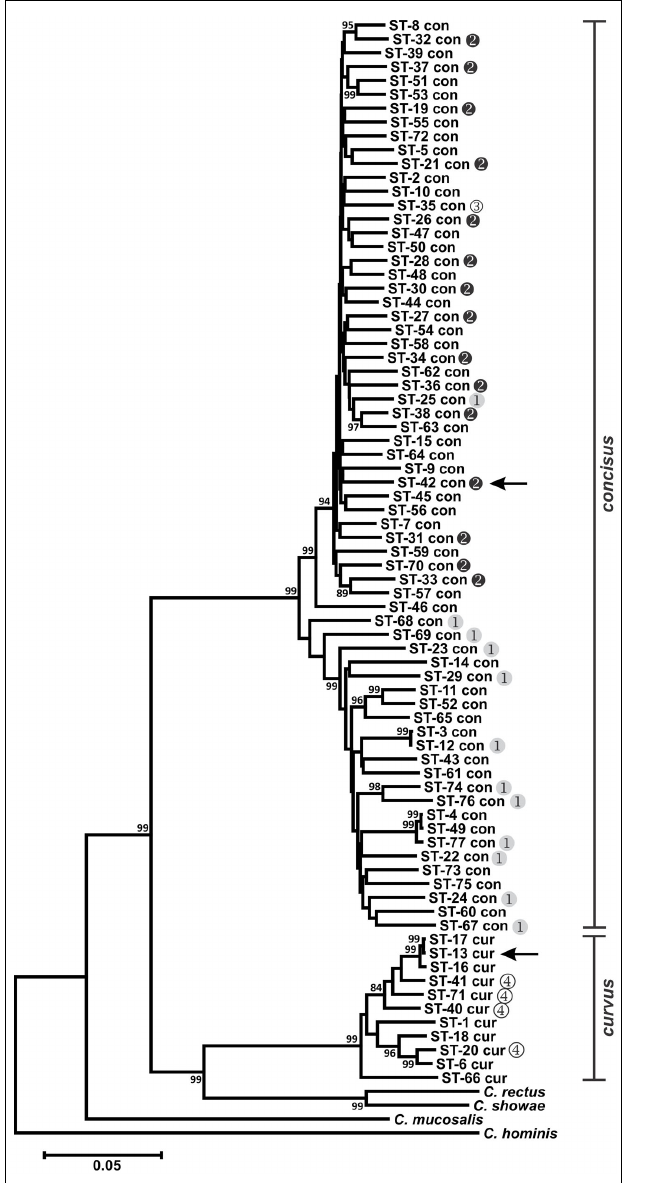
FIGURE 1 | Dendrogram of C. concisus and C. curvus STs. Allele sequences for each strain were concatenated in the order aspA - atpA - glnA - gltA - glyA - ilvD - pgm and aligned using CLUSTALX . The dendrogram was constructed using the neighbor-joining algorithm and the Kimura two-parameter distance estimation method (Kimura, 1980). Bootstrap values > 75%, generated from 1000 replicates, are shown at the nodes. Scale bar represents substitutions per site. Genomospecies 1–4 designations, as assigned by Aabenhus et al. (2005), were placed to the right of STs representing strains from that study. Arrows indicate the STs of the C. concisus and C. curvus genome-sequenced strains.The dendrogram contains also the concatenated aspA , atpA , glnA , gltA , glyA , ilvD , and pgm allele sequences of Campylobacter rectus , Campylobacter showae , Campylobacter mucosalis , and Campylobacter hominis .These allele sequences were extracted from draft ( C. rectus , C. showae , and C. mucosalis ) and completed ( C. hominis ) genome sequences.